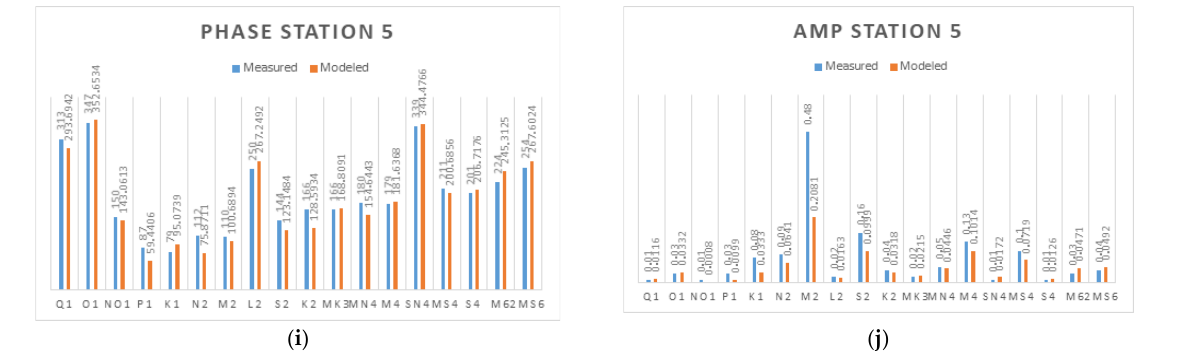
Figure 4. Histograms for modeled results for Phase (degrees) and Amplitude (meters) in comparison with the measured. ( a ) Phase S1; ( b ) Amplitude S1; ( c ) Phase S2; ( d ) Amplitude S2; ( e ) Phase S3; ( f ) Amplitude S3; ( g ) Phase S4; ( h ) Amplitude S4; ( i ) Phase S5; ( j ) Amplitude S5.